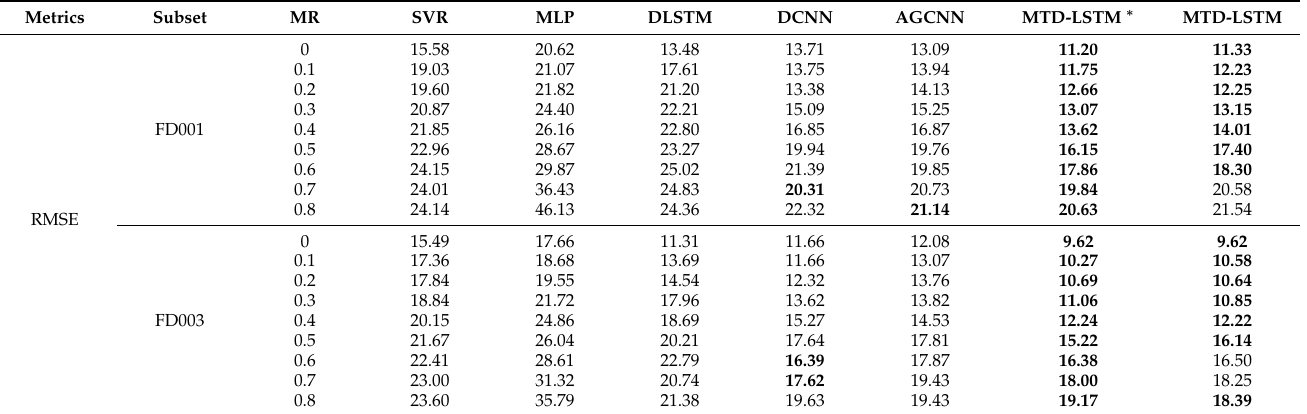
Table 5. RMSE and scores of compared methods on C-MAPSS under different missing rates (MR).